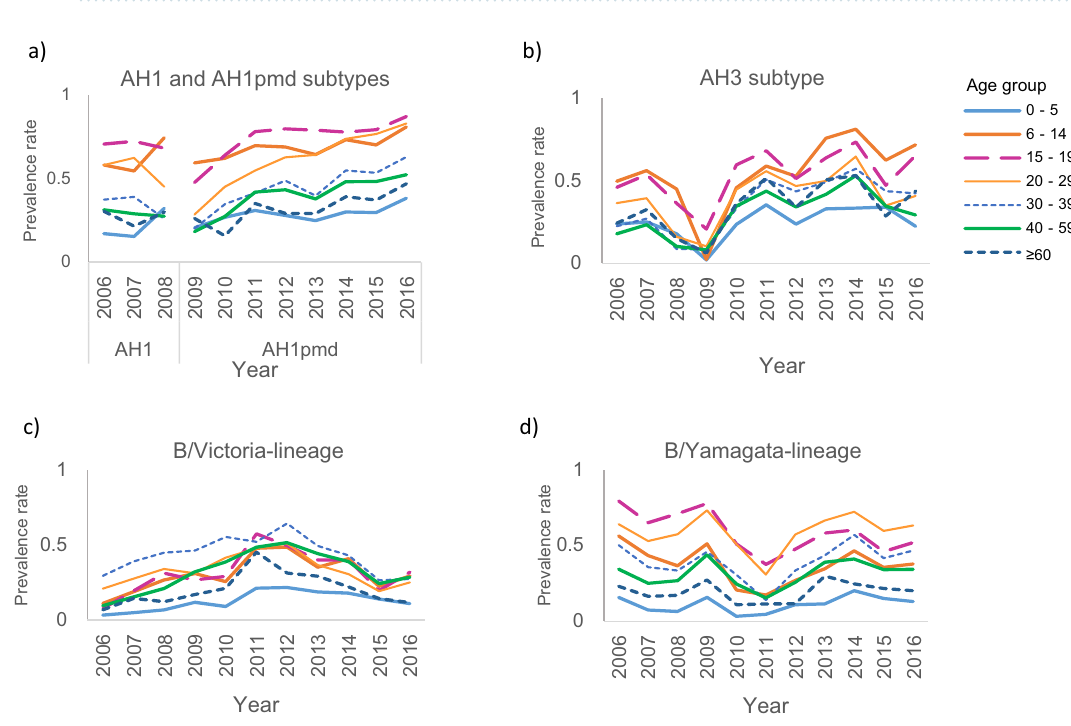
Figure 3. Biennial cycle of influenza virus B lineages and influenza prevalence rate in children (≤ 19 years old). ( a ) Biennial cycle of increased influenza prevalence rates in children and the prevalence of B lineages (the data exclude epidemic seasons during which the novel swine influenza virus emerged [between the 2009–2010 and 2011–2012 seasons], as indicated by the dotted lines). ( b ) Average influenza prevalence rate in children and average prevalence of B lineages for the low-prevalence period (Season A: 2005–2006, 2007–2008, 2012–2013, and 2014–2015 seasons) and high-prevalence period (Season B: 2006–2007, 2011–2012, 2013–2014, and 2015–2016 seasons).